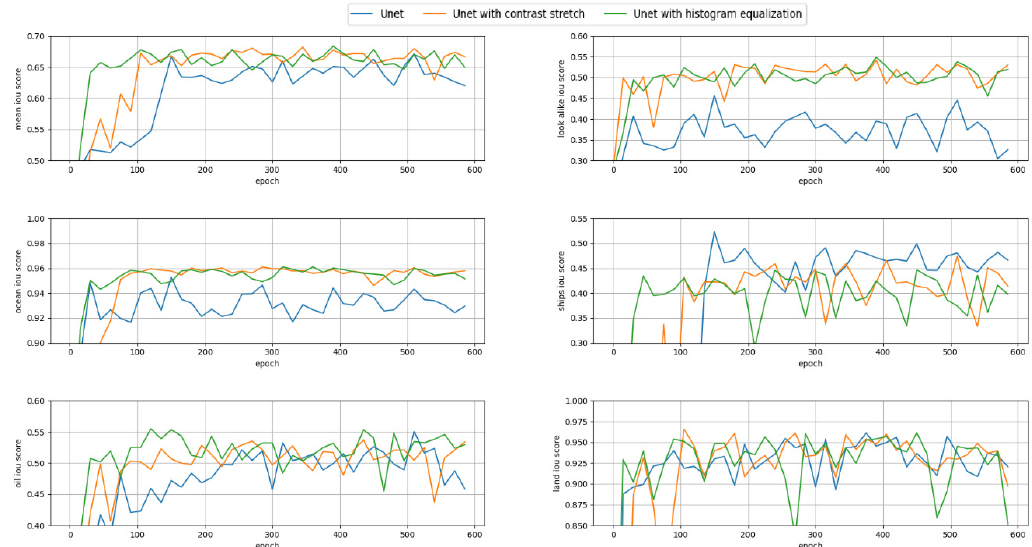
Figure 8. Test set IoU scores of the models utilizing the Unet architecture, measured every 25 epochs.